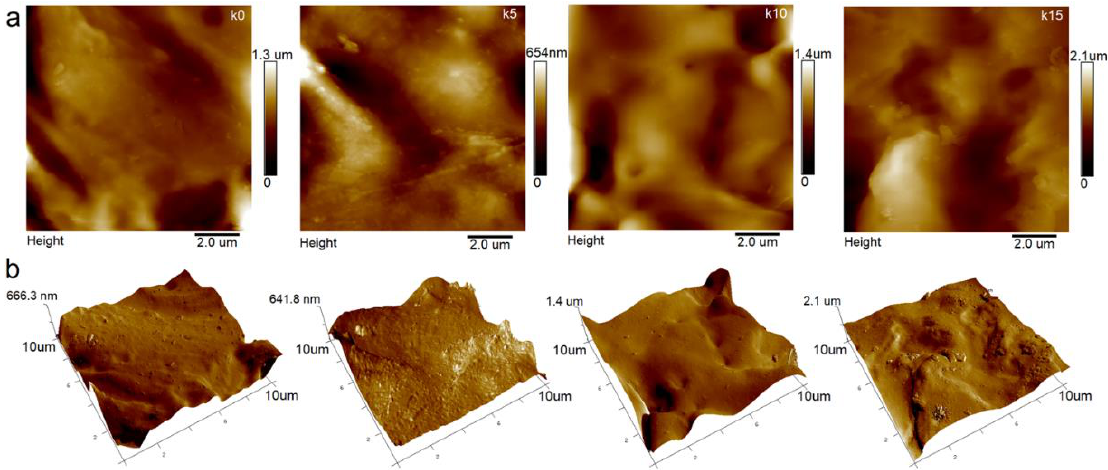
Figure 2. X-ray diffraction patterns of, ( a ) k0, k5, k10, k15 films; ( b ) an enlarged range of diffraction pattern for 2θ from 15° to 22°.